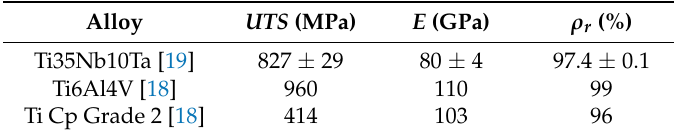
Table 2. Characterization of the Ti35Nb10Ta alloy.